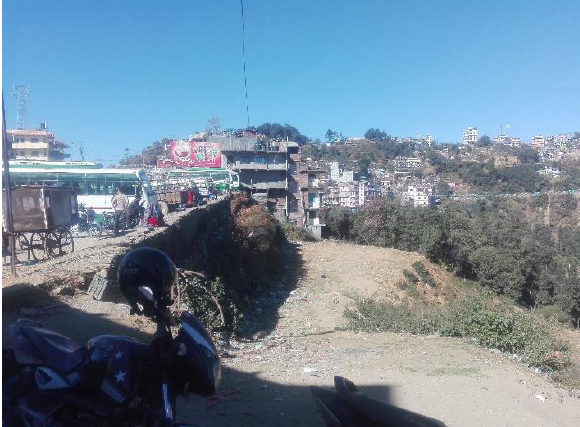
Figure 6. Unmanaged bus park area in BagBazaar of Amargadhi Smart City in Dadeldhura